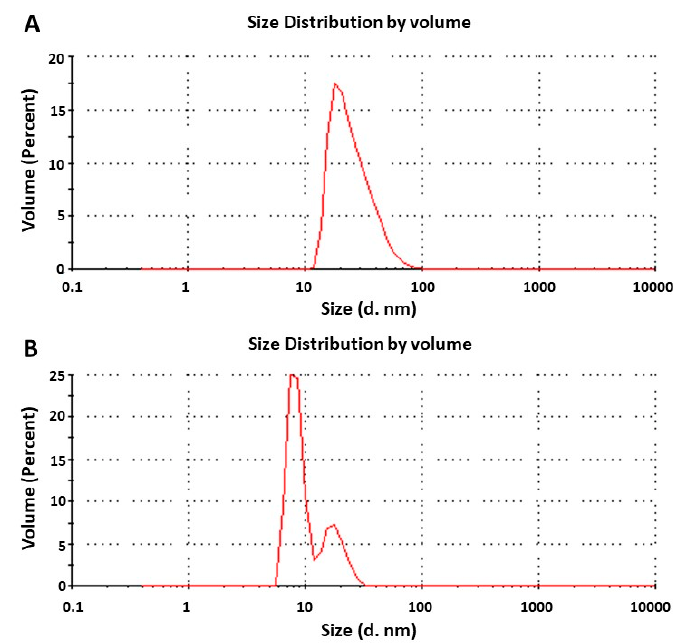
Figure 5. Dynamic light scattering (DLS) diagrams of the droplet diameter in the nanoemulsions: ( A ) 2.5:5:92.5; and ( B ) 5:10:85.